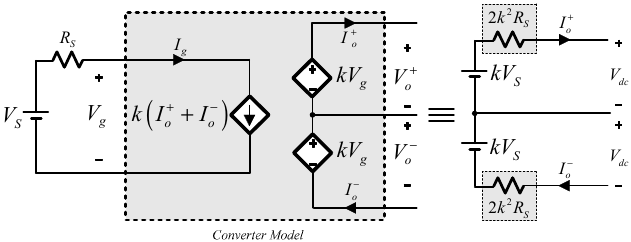
Figure 5. Converter model from output terminals.